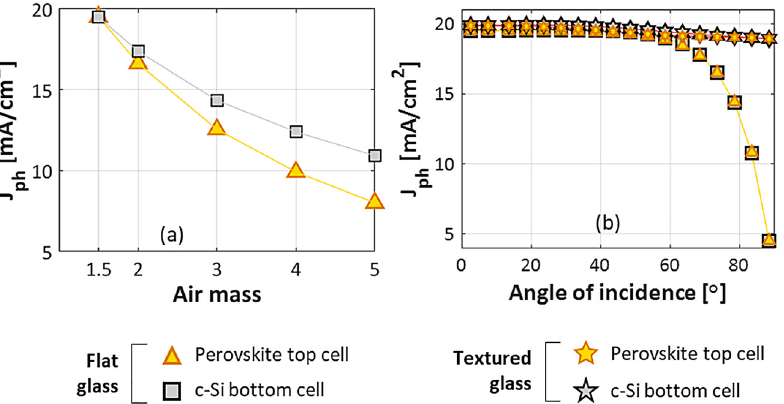
Figure 5: Implied photocurrent density of encapsulated 2T tandem with c-Si bottom cellpassivatedwithpoly-SiO x asfunctionof (a) AM and (b) angle of